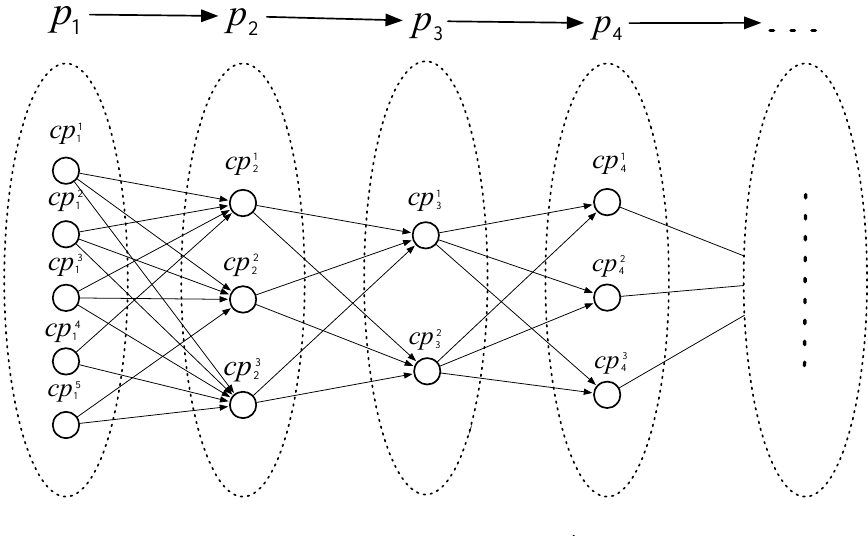
Figure 4. The HMM graph G ′.